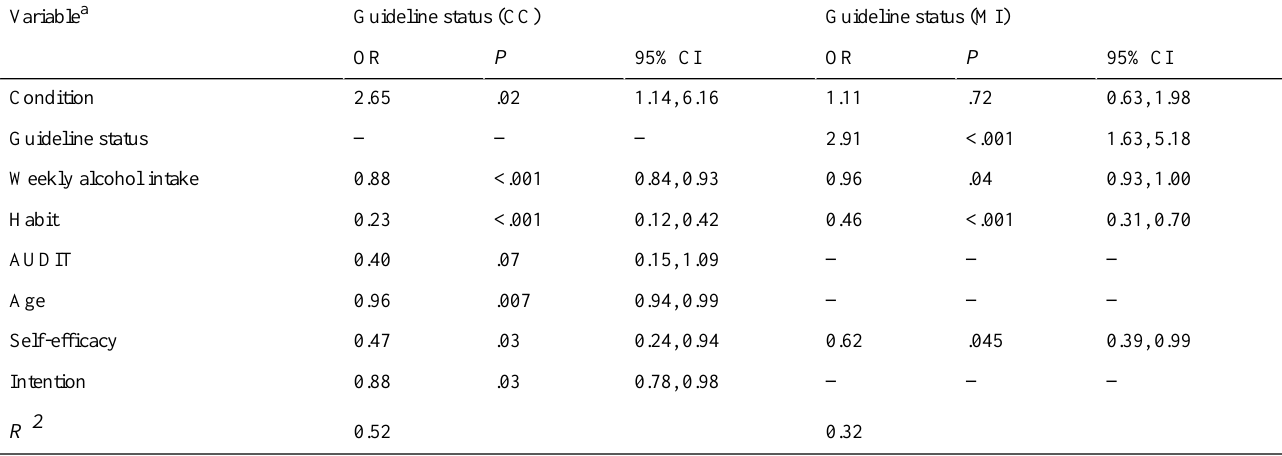
Table 2. Results of the logistic regression analysis (backward method) with guideline status (0=not complying; 1=complying) after 6 months as dependent variable among complete cases (CC, n=197) and after applying multiple imputations (MI,